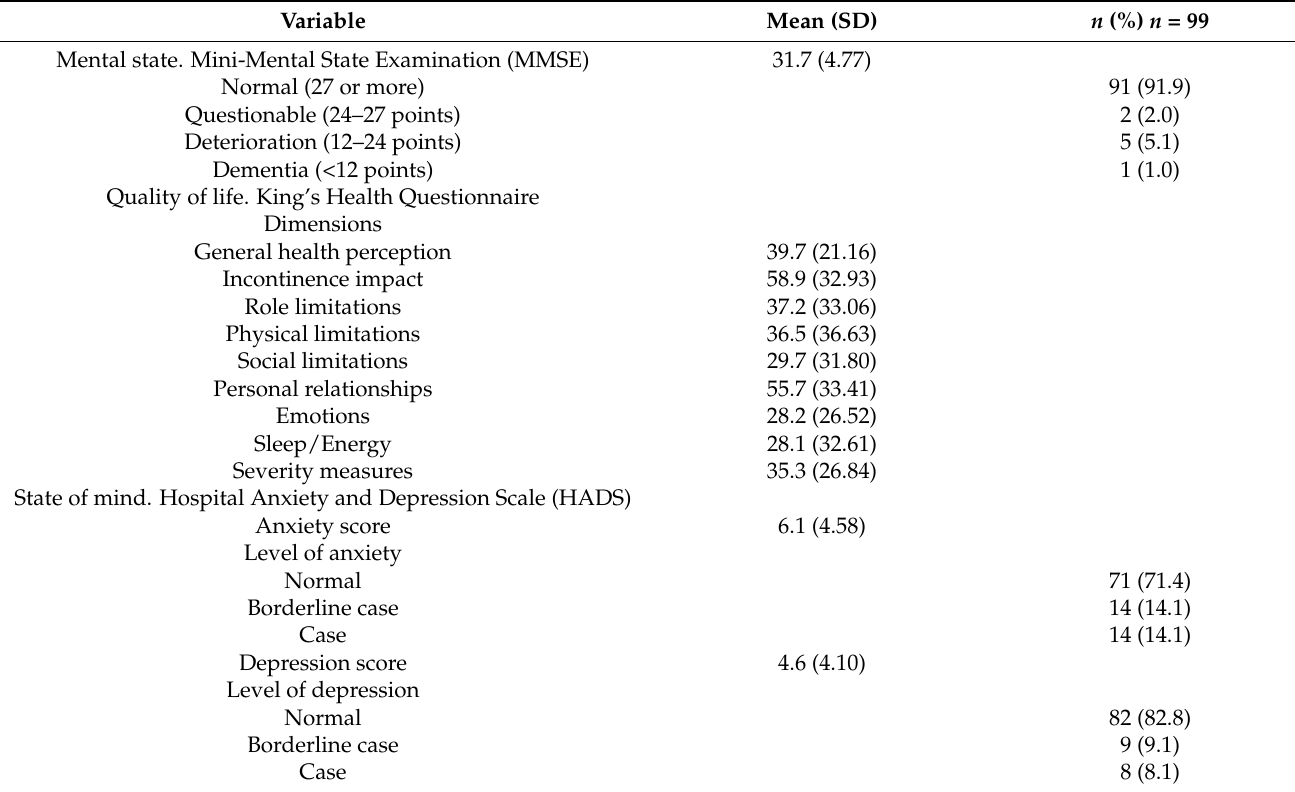
Table 5. Cognitive characteristics, quality of life, and state of mind of the patients under study at first